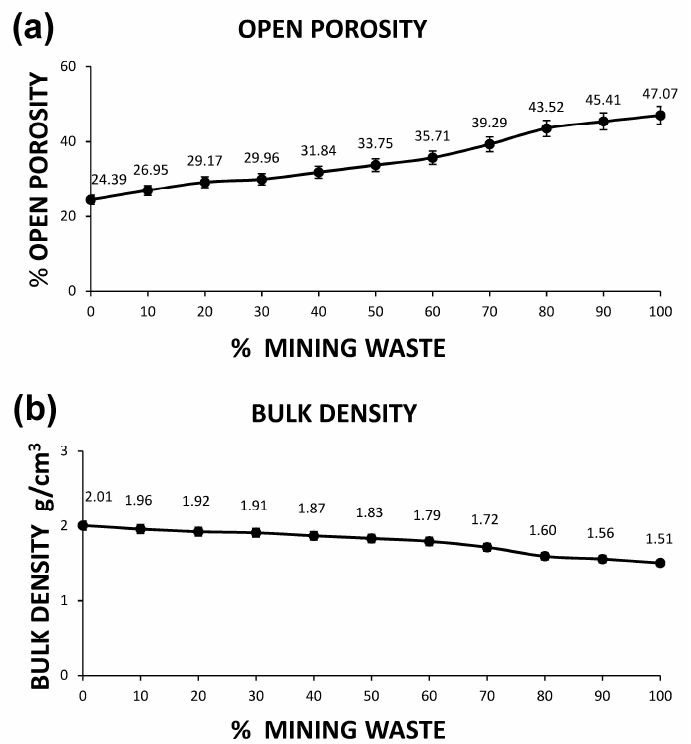
Figure 4. Physical properties of ceramic families with clay and mining residue after sintering ( a ) open porosity and ( b ) bulk density.